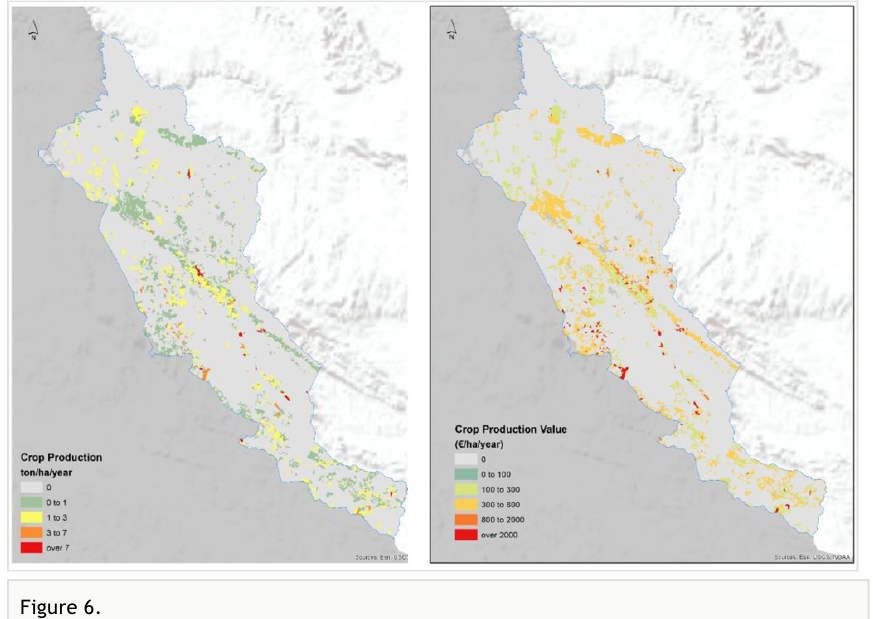
Spatial quanti fi cation (left) and economic valuation (right) of Crop Production service [ 1.1.1.1 ] within